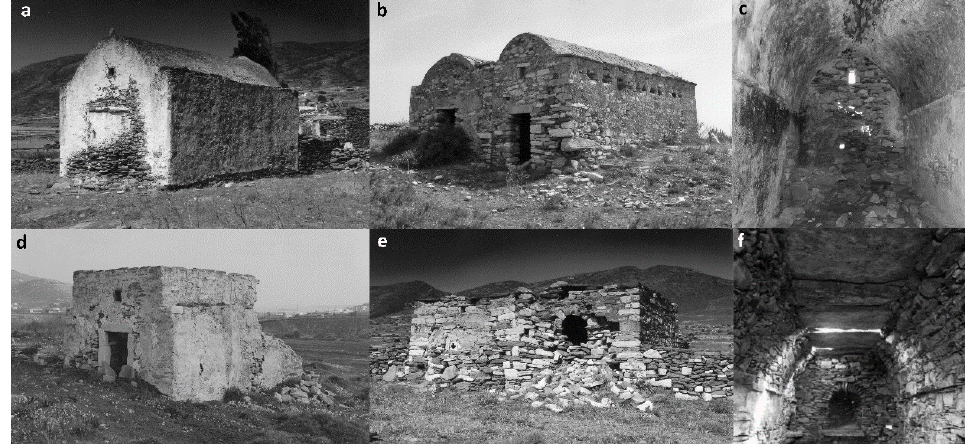
Figure 5. Representative examples of rural churches on Paros. ( a ). Pointed barrel-vaulted, free- standing church; ( b ). Barrel-vaulted (north chapel) and pointed barrel-vaulted (south chapel) twin churches; ( c ). Pointed barrel vault, interior; ( d ). Pseudo-vaulted free-standing church; ( e ). Pseudo- vaulted twin churches; ( f ). Pseudo vault with stone slabs, interior (photos by the author).